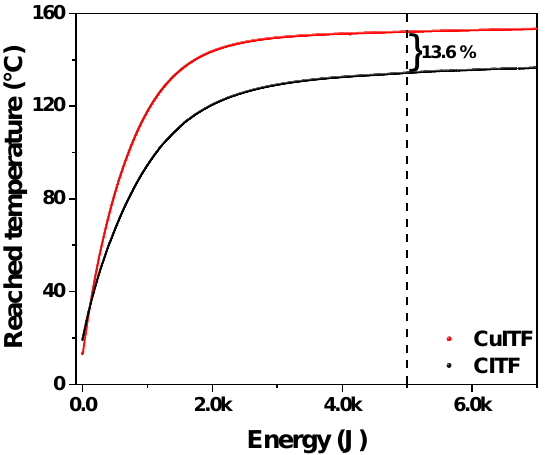
Figure 6. The reached temperature curves as a function of energy consumed for each furnace.